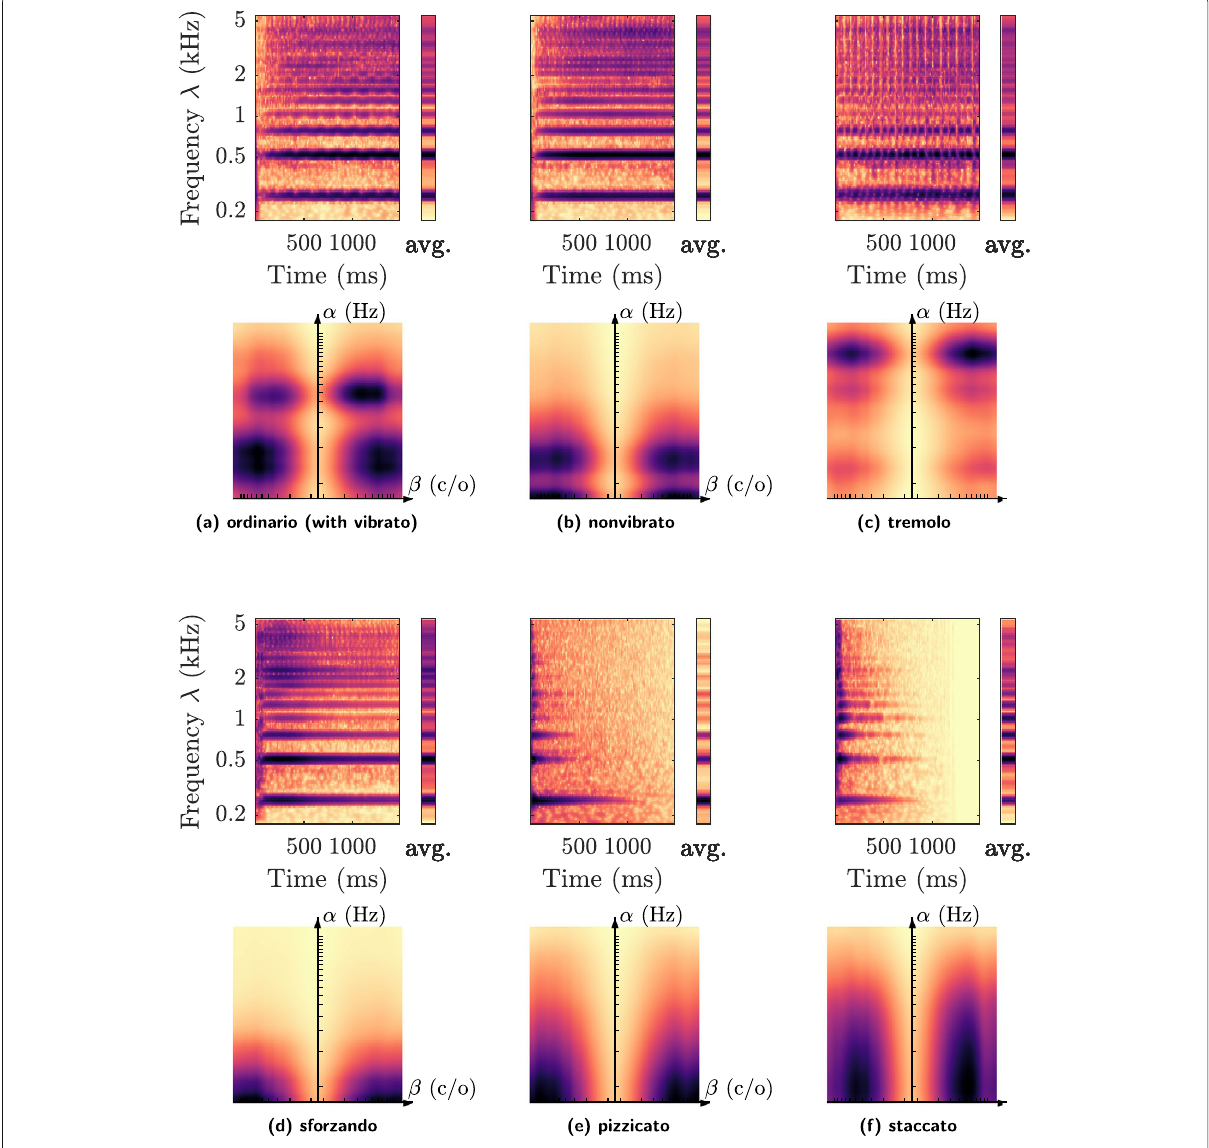
Fig. 3 Six playing techniques of the violin. Subfigures: a ordinario (with vibrato), b nonvibrato, c tremolo, d sforzando, e pizzicato ( laissezvibrer , i.e., let ring), and f staccato. In each subfigure, the top image shows the wavelet scalogram as a function of time t (in seconds) and frequency λ (in Hertz). Conversely, the bottom image shows the average time–frequency scattering coefficients, as a function of temporal modulation rate α (in Hertz) and frequential modulation scale β (in cycles per octave). Darker shades denote greater values of acoustic energy. See Section 4 for